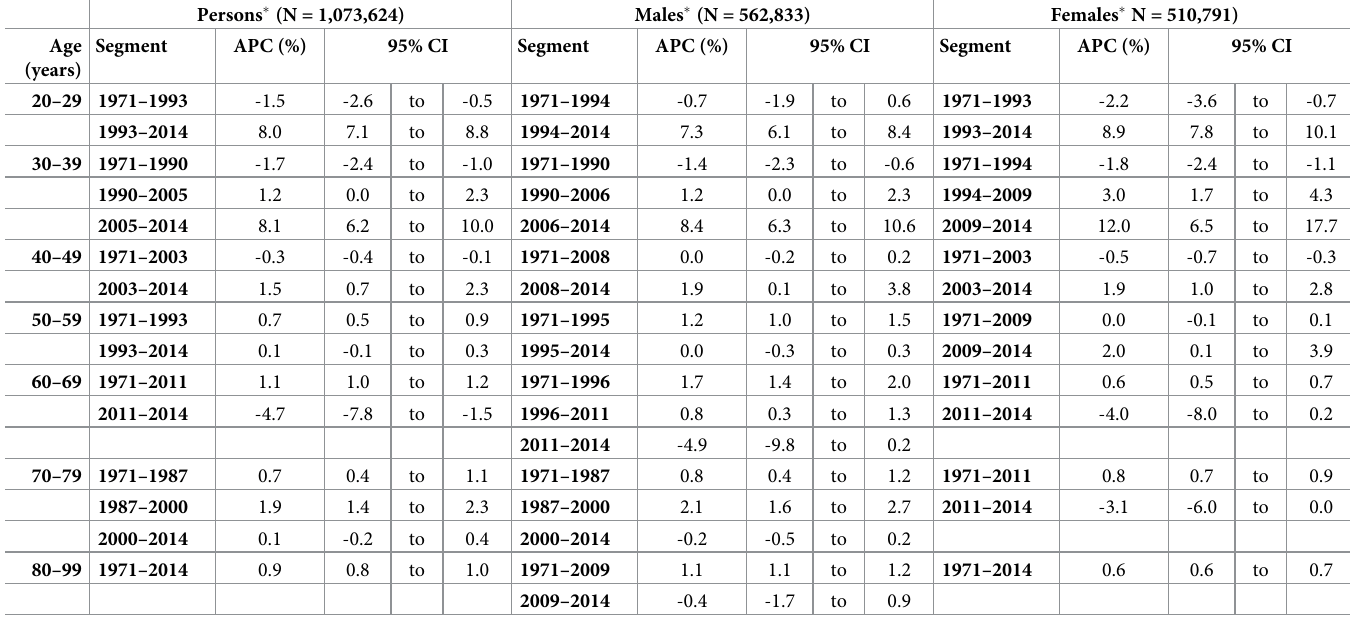
Table 1. Annual Percentage Change (APC, %) in colorectal cancer incidence rates by sex, age and calendar period (segment) of diagnosis: England, 1971–2014. Persons � (N = 1,073,624) Males � (N =